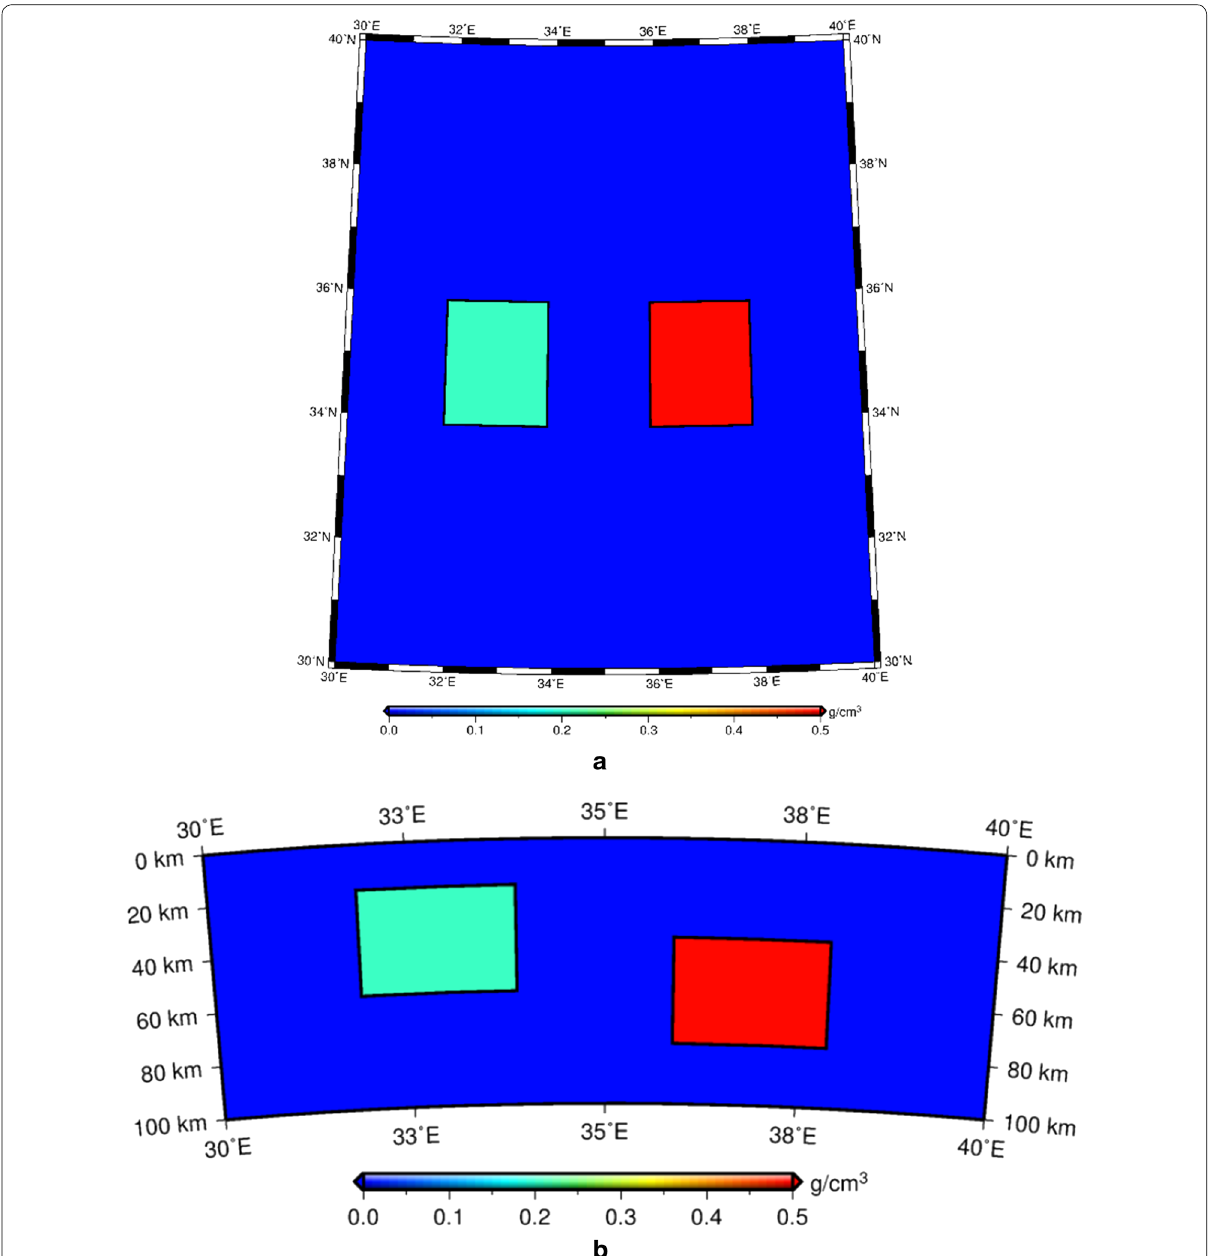
Fig. 8 Artificial synthetic models (two composite models). a Horizontal slice of the artificial synthetic model with a radial length of 1698 km, b verti- cal profile of the artificial synthetic model with latitude of